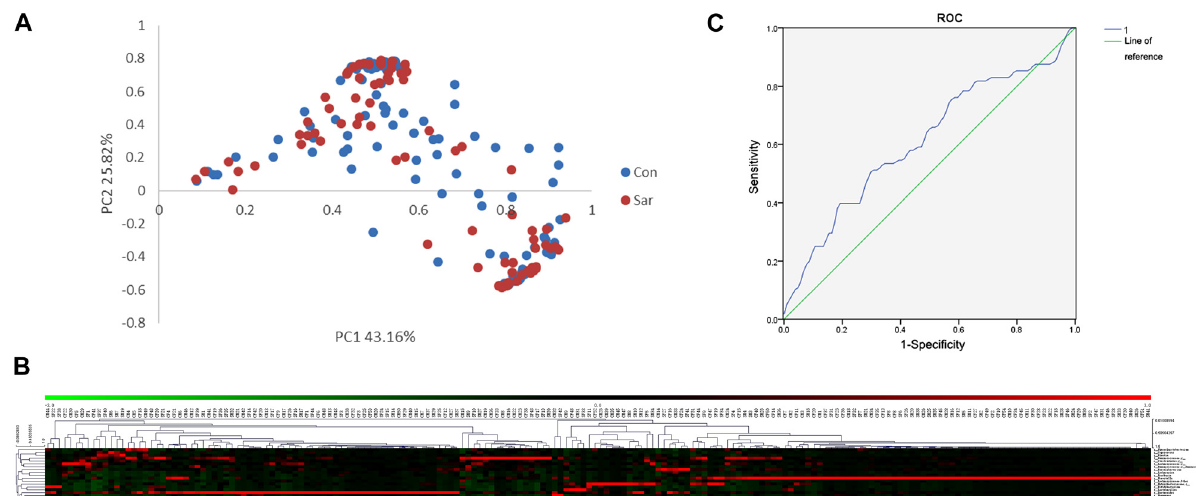
Figure 2: PCA map of the intestinal microbiome in the control group and sarcopenia group (A). Heatmap of gut microbiota abundance. “ CF ” means controlfemale group; “ CM ” means control male group; “ SF ” means sarcopenia femalegroup; “ SM ” means sarcopenia male group(B). ROC curves of the sarcopenia group for three indexes (C) (AUC=0.671, 95% con fi dence interval,